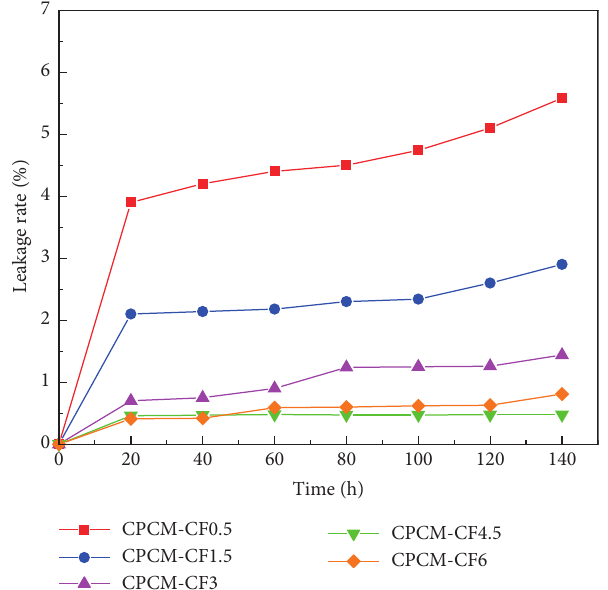
Figure 6: The leakage rates of the CPCMs.